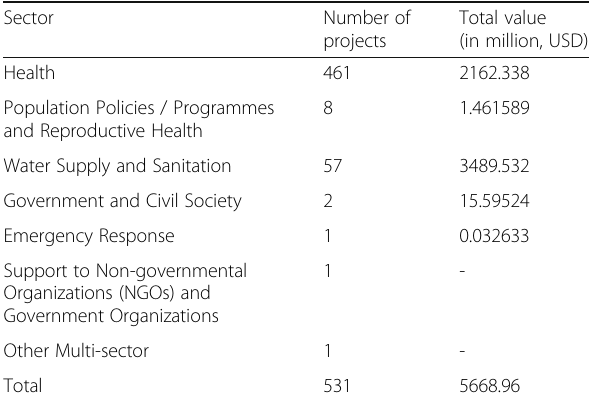
Table 2 Total number and value of projects in the public health